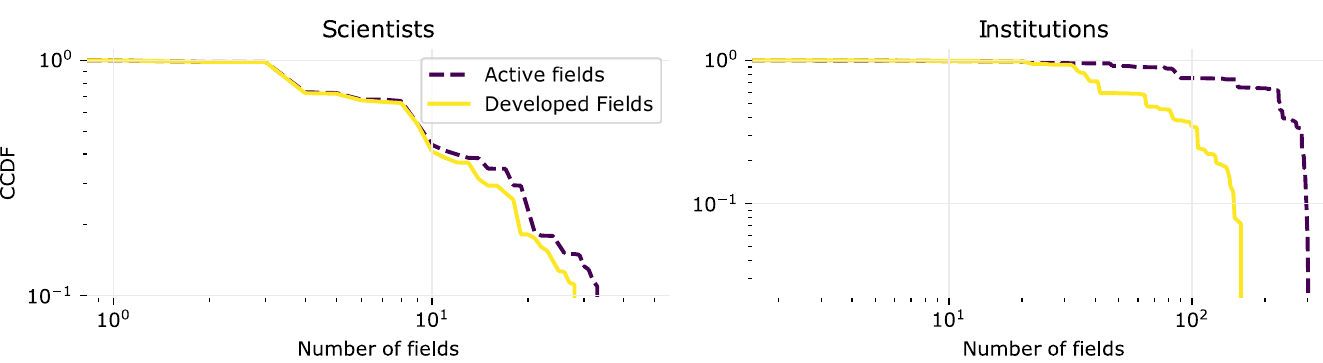
Fig 5. Distribution of number of active and developed fields. Complementary Cumulative Distribution Function of the number of active/developed fields for scientists and institutions (data from years [2000, 2014]).